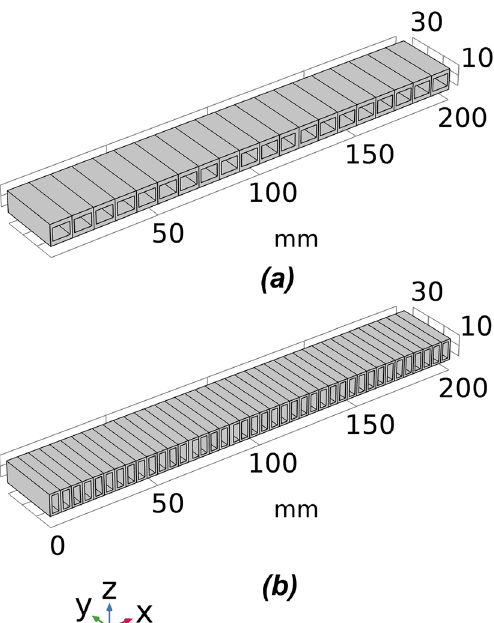
Figure 2. The cellular beam structures with lengths of voxels 10 mm and 5 mm, respectively, for ( a ) 20 voxel and ( b ) 40 voxel models (Images are created by the authors using Solidworks Educational Version 30.3.1.2 2022-